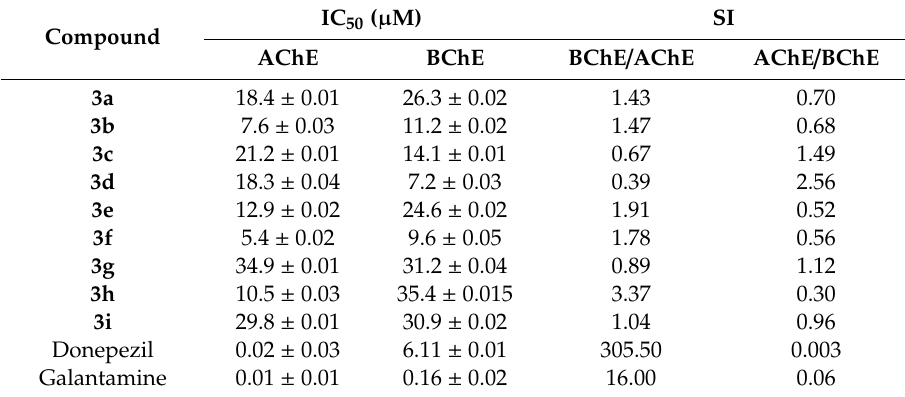
Table 3. AChE and BChE inhibitory activities of compounds 3a–i.